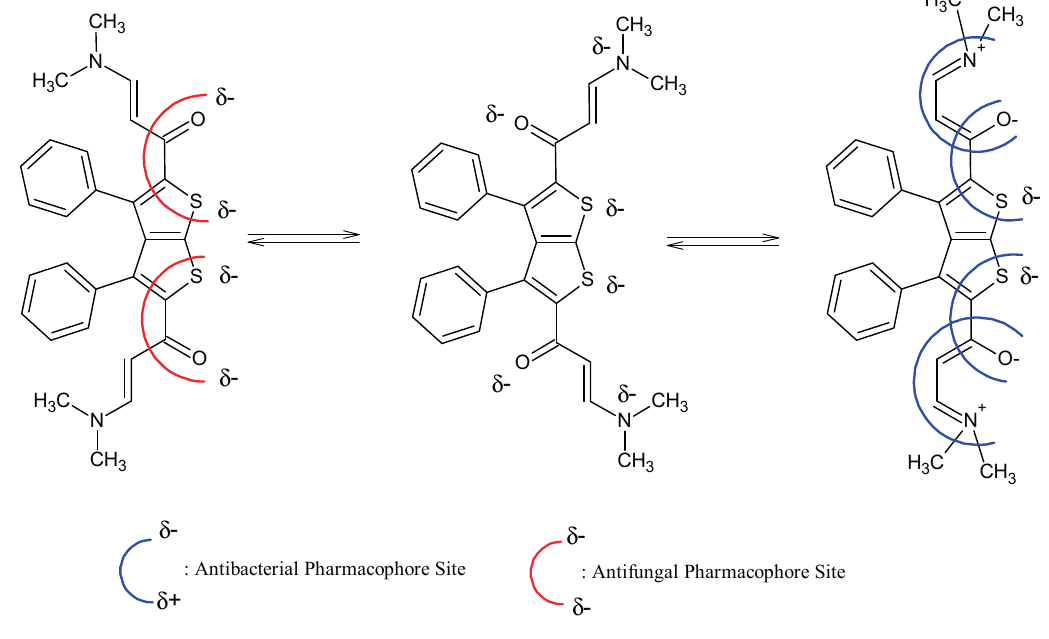
Figure 4. Identification of steric hindered antibacterial and antifungal pharmacophoric sites of compound 1